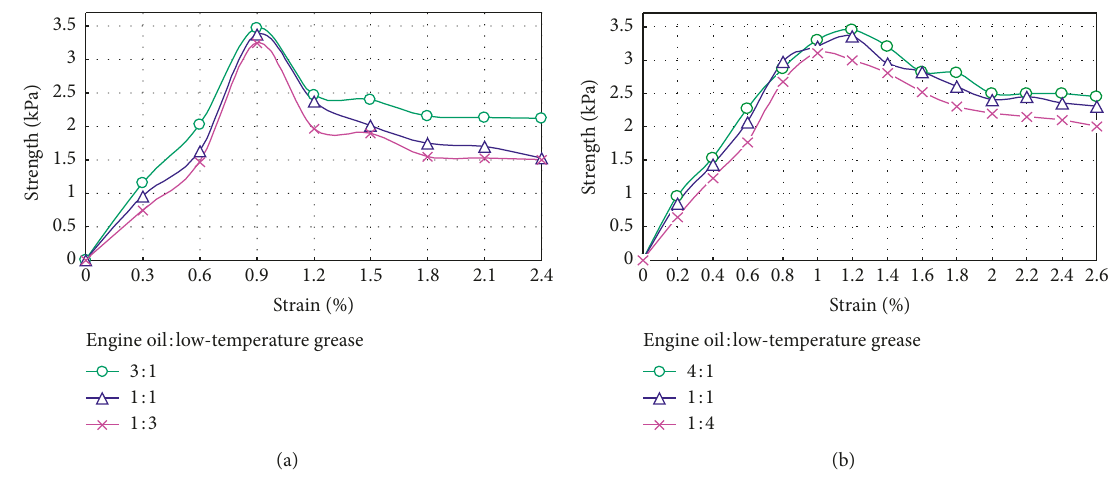
Figure 3: Stress-strain curve in various grease ratios. (a) Ratio between sand and soil 1: 3. (b) Ratio between sand and soil 1:5.